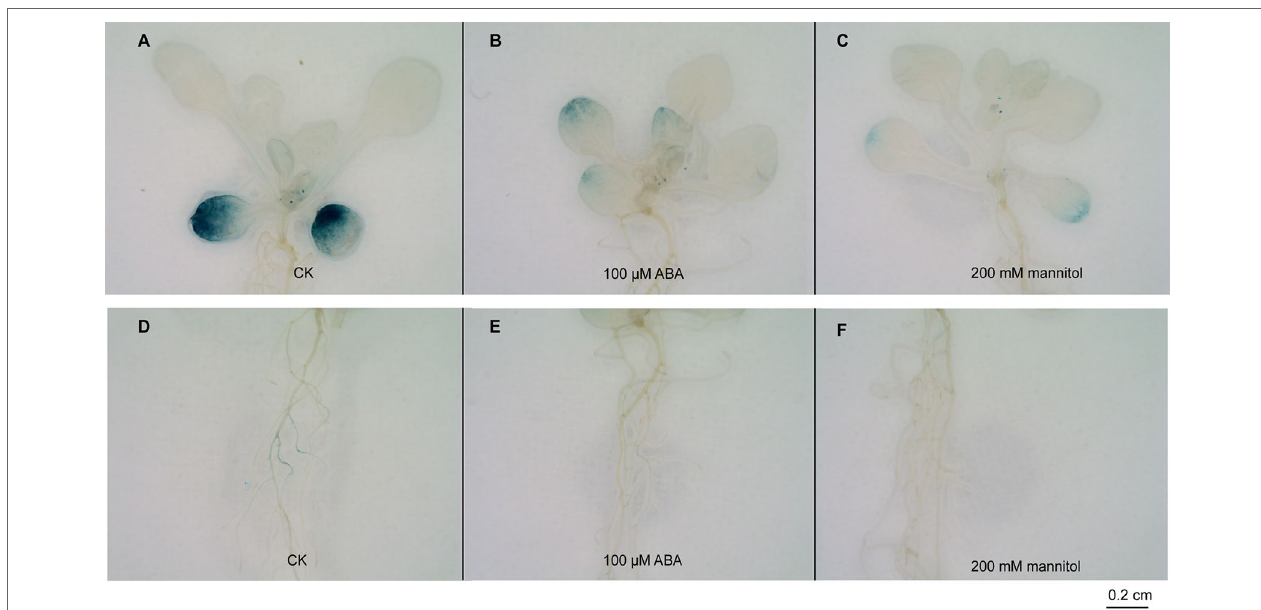
FIGURe 4 | Histochemical GUS assays in ProGhWRKY91 ::GUS transgenic Arabidopsis plants. (a – C) GUS staining of the leaves under control, ABA, and mannitol treatments. (D – F) GUS staining of the roots under control, ABA, and mannitol treatments. Bar = 0.2 cm.